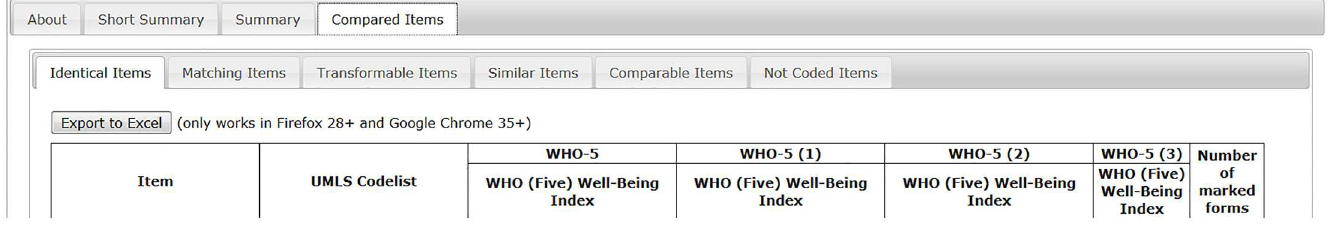
Fig 7. Result of multiple forms comparison.